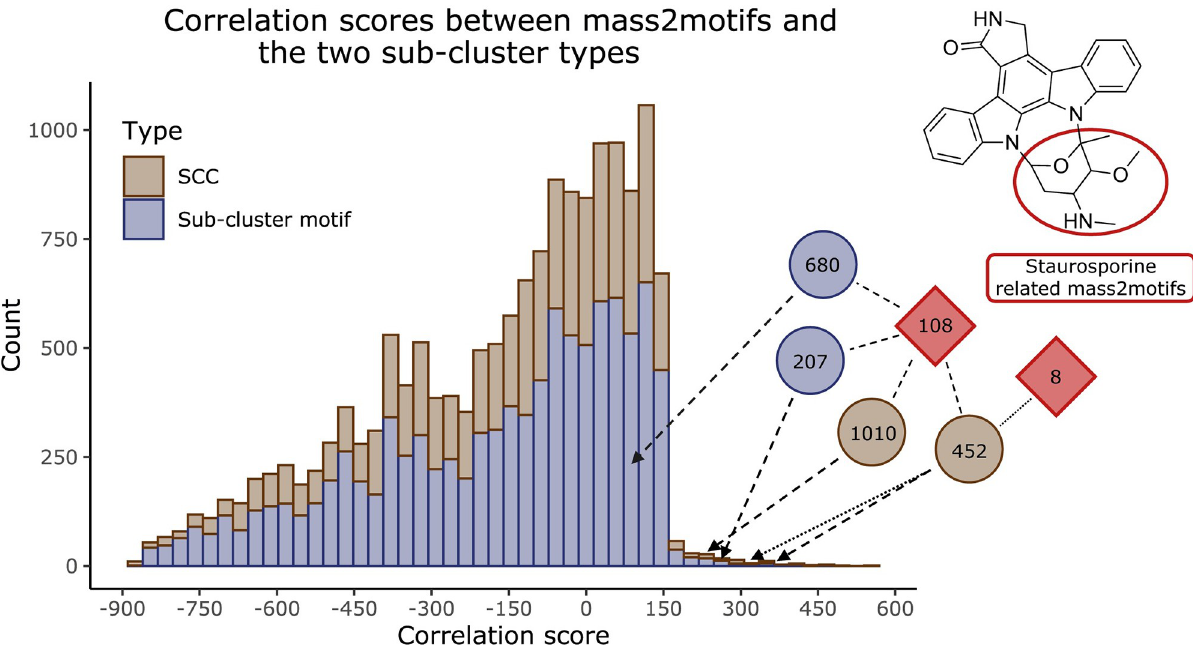
Fig 6. Metabologenomic correlation scores between sub-clusters and mass2motifs. Stacked histogram of the correlation scores across the Streptomyces/Salinispora strains between the mass2motifs paired with either the SCCs or sub-cluster motifs with a p-value below 0.1. Highlighted with their scores are the pairs mass2motif_108 with SSC_452, SSC_1010, sub-cluster_motif_207 and sub-cluster_motif_680, and the pair mass2motif_8 with SSC_452. The aforementioned sub-cluster motifs (blue) and SCCs (brown) are responsible for sugar synthesis in staurosporine, while both mass2motifs (red) are staurosporine